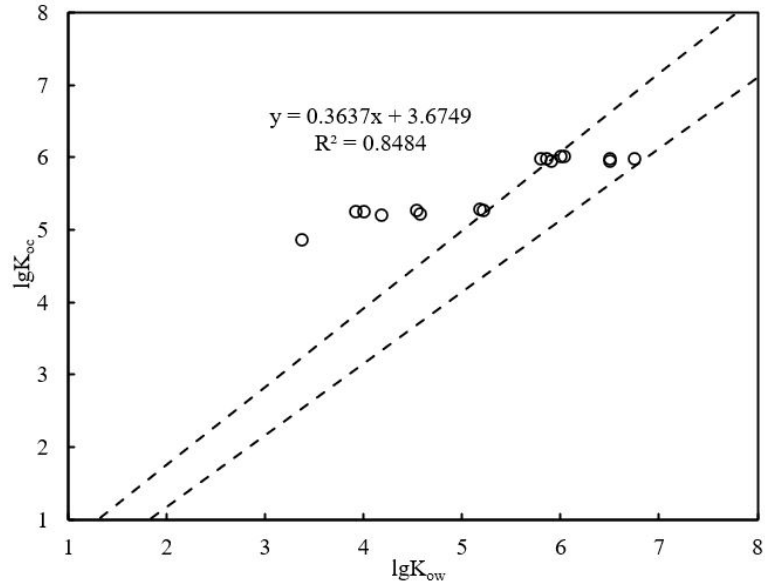
Figure 7. Relationship between lgK oc and lgK ow in sediment–water interface.